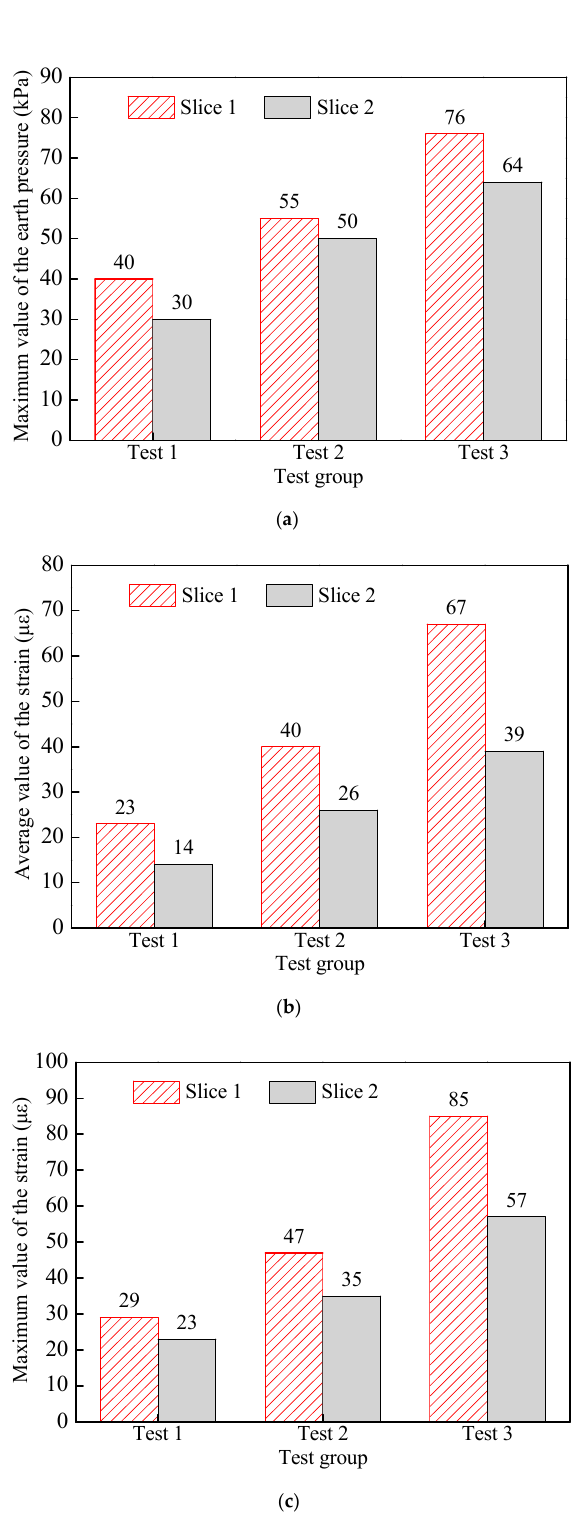
Figure 7. Measured accumulative strains and the earth pressure in the forced vibration tests: ( a ) maximum value of the earth pressure; ( b ) average value of the strain; and ( c ) maximum value of the strain.